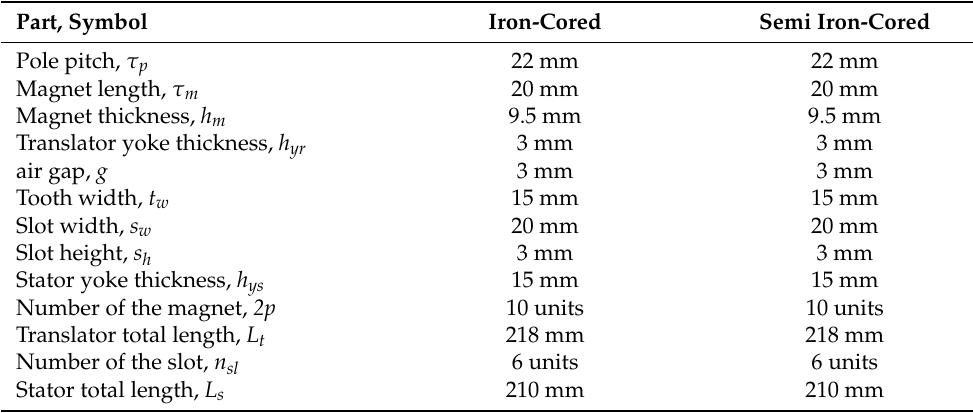
( b ) Figure 9. Sample of: ( a ) absolute highest significant wave height map; and ( b ) average significant wave height map in January during period of 2000–2010. The color gradation measures the height in meters [48].